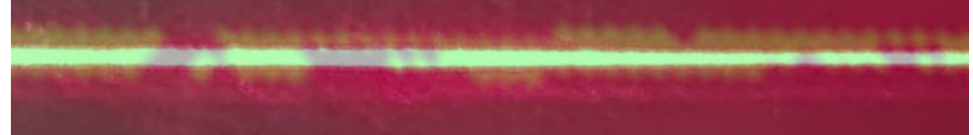
Figure 7. Image ‐ processing flow after neural network segmentation. ( a ) original image ( b ) binarization ( c ) image after recognition by the neural network ( d ) ROI extraction